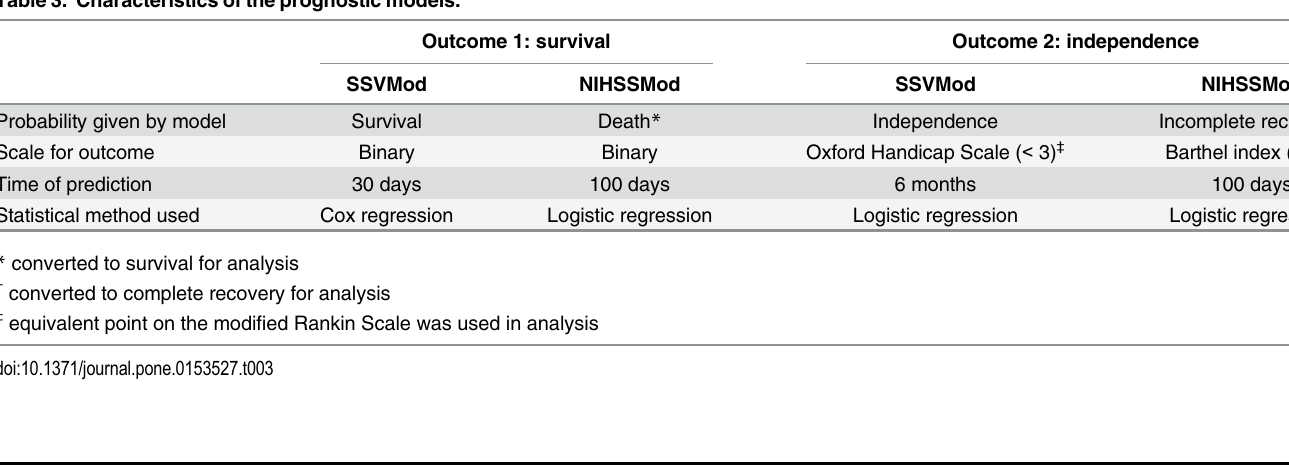
Table 3. Characteristics of the prognostic